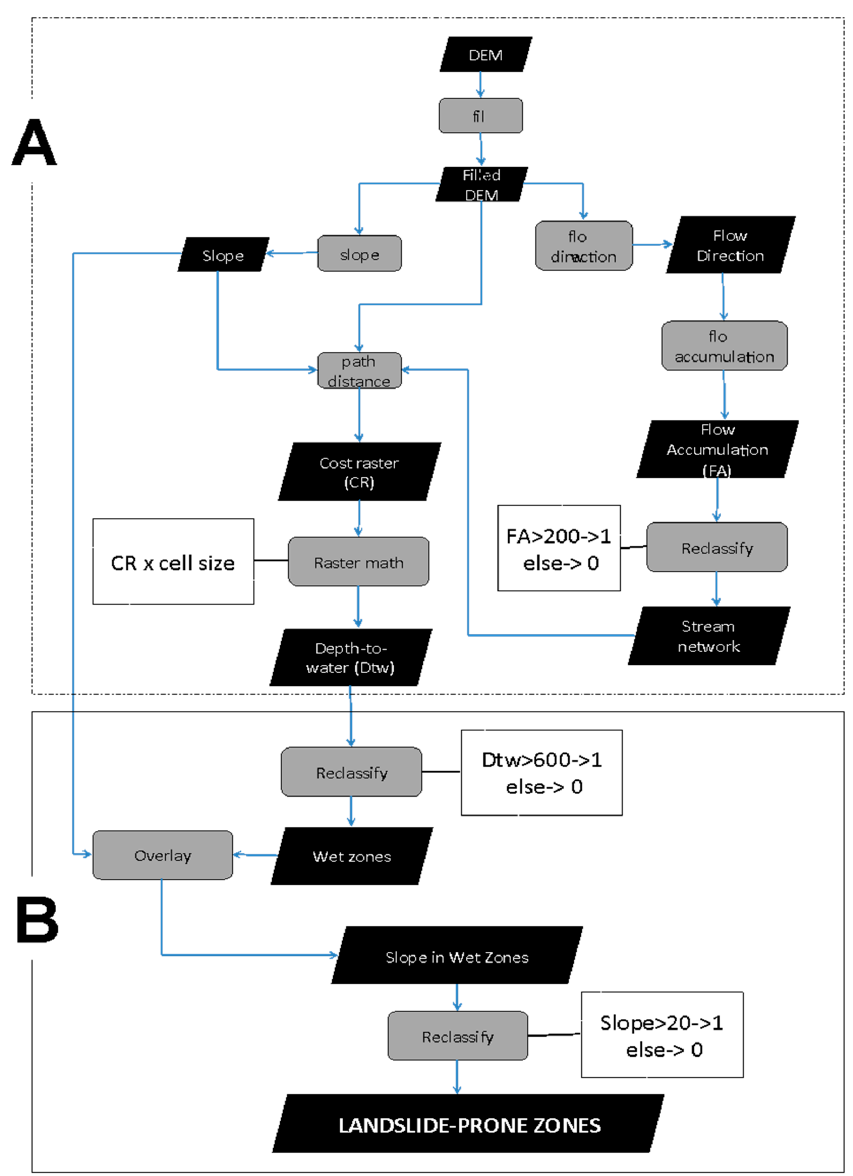
Figure 1. Cartographic model for the GIS-based tool for detecting landslide-prone zones. ( A ) steps for calculating the carto-graphic depth-to-water index (D tw ); ( B ) steps for detecting landslide-prone zones by overlaying steep and potentially wet soil zones. Black boxes: raster layer; Grey boxes: GIS-based operations; White boxes: reclassify operations specific details for this case study.